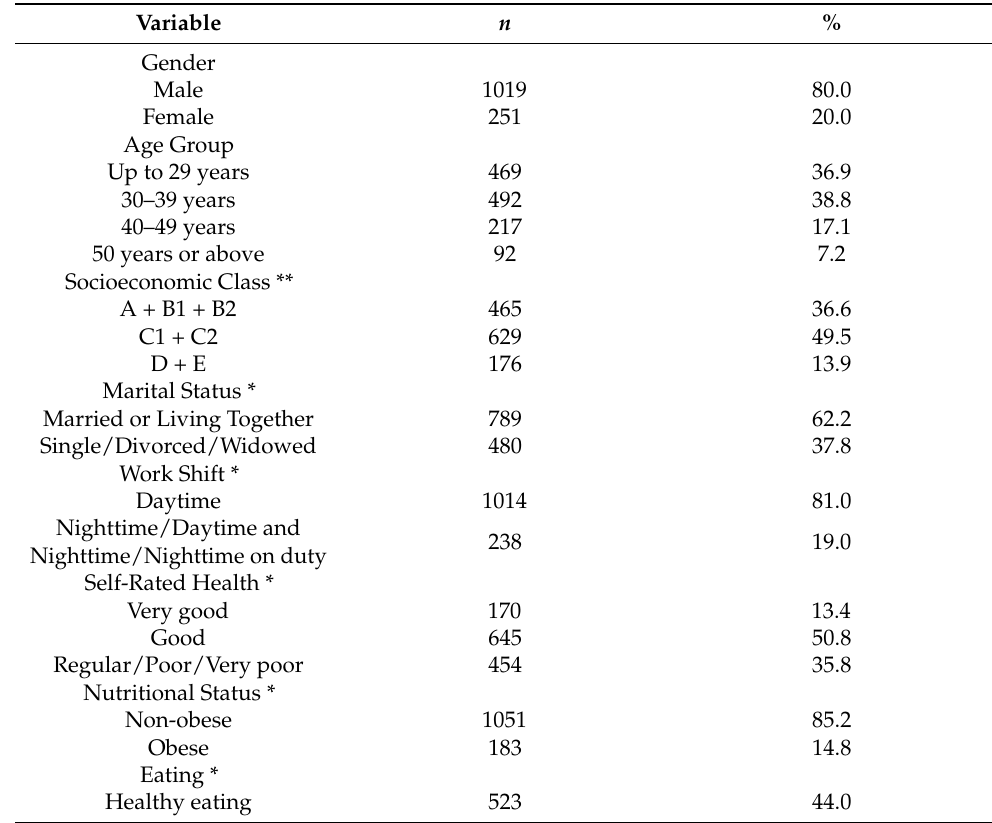
Table 1. Demographic, socioeconomic, clinical, and behavioral aspects of